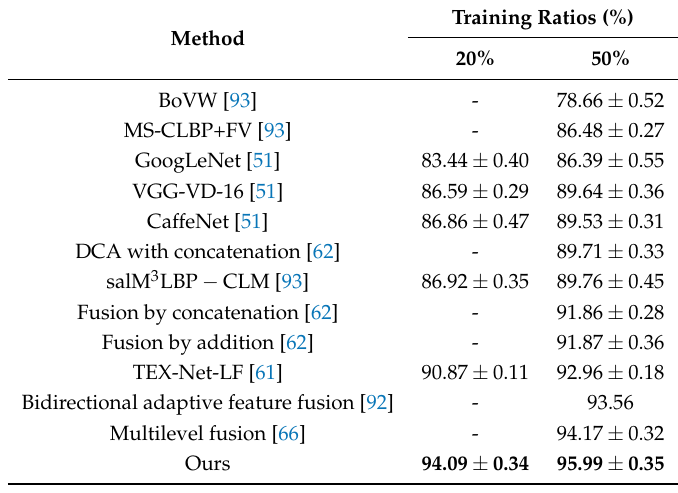
Table 6. Comparison of classification accuracy with the state-of-the-art methods on the AID